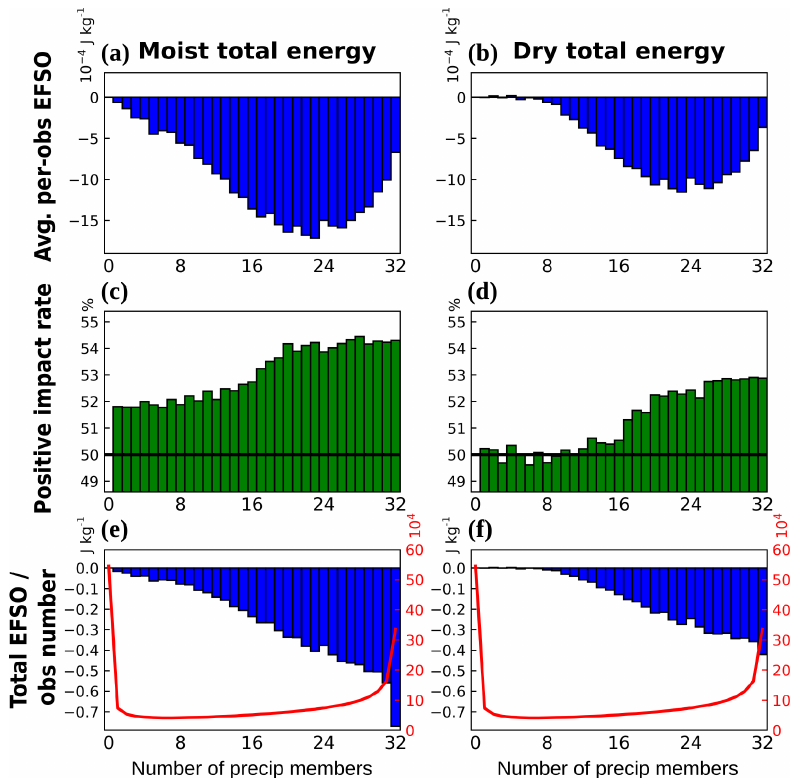
Figure 2. EFSO statistics for TMPA observations grouped by the number of precipitating members in the background and measured by (a, c, e) the moist total energy norm, and (b, d, f) the dry total energy norm in 6h forecasts during the year 2008. (a, b) Average per-obs EFSO (10 − 4 Jkg − 1 ). (c, d) Percentage of observations with positive impacts. (e, f) Total EFSO per cycle (Jkg − 1 ). Also shown in red curves in (e, f) are the total numbers of observations (i.e., EFSO samples) in all 293 offline cycles (10 4 ; secondary y